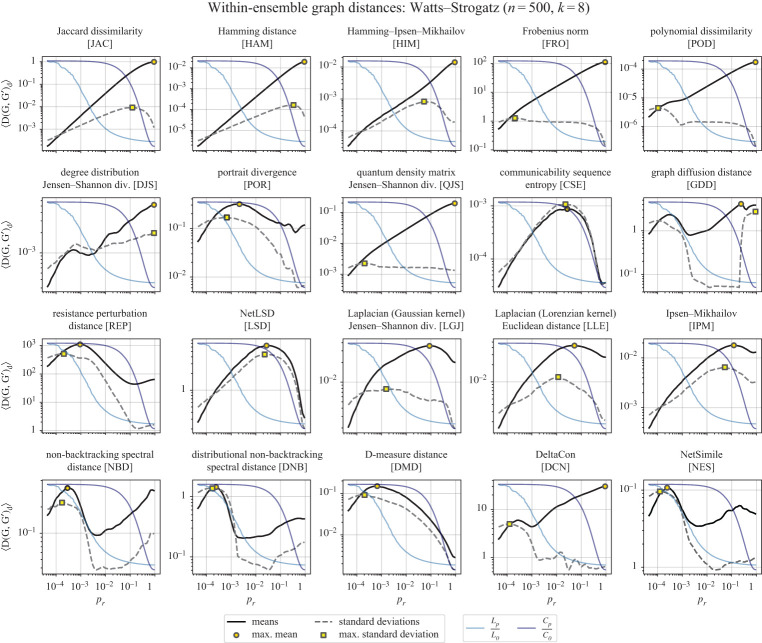
Mean and standard deviations of the within-ensemble distances for Watts–Strogatz networks. Here, we generate pairs of Watts–Strogatz networks with a fixed size and average degree but a variable probability of rewiring random edges, pr. In each subplot, we also plot the clustering and path length curves as in the original Watts–Strogatz paper [19] to accentuate the ‘small-world’ regime with high clustering and low path lengths. The mean within-ensemble graph distance is plotted as a solid line with a shaded region around for the standard error (〈D〉 ± σ〈D〉; note that in most subplots above, the standard error is too small to see), while the dashed lines are the standard deviations. (Online version in colour.)